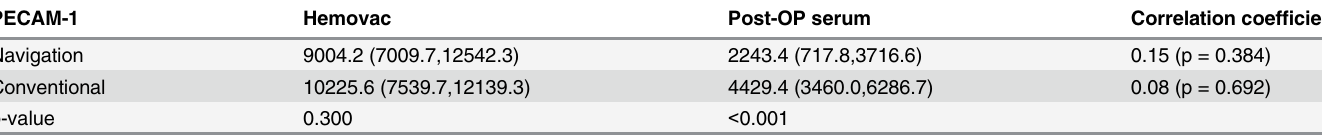
Table 7. Correlation of PECAM-1 concentrations (unit: ng/mL) in hemovac samples and postoperative serum